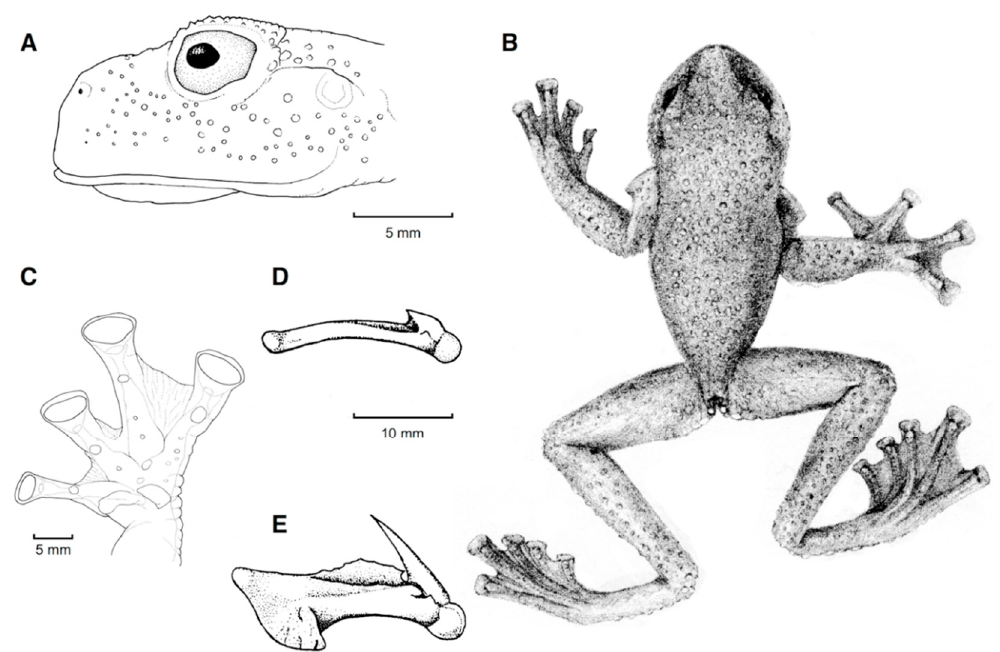
Figure 35. Centrolene geckoidea . ( A ) Head in lateral view, male, KU 116447. ( B ) Drawing of holotype, not to scale [83]. ( C ) Hand in ventral view, male, KU 116447; drawing by Juan M. Guayasamin. ( D ) Humeral spine of adult female; modified from Rueda-Almonacid [111]. ( E ) Humeral spine of adult male; modified from Rueda-Almonacid [111].